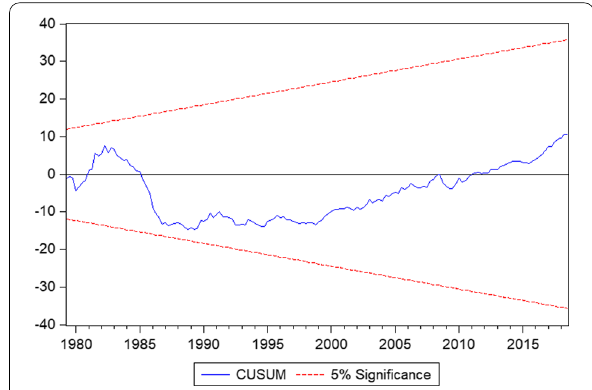
Fig. 6 CUSUM test of recursive residuals of inflation VAR equation